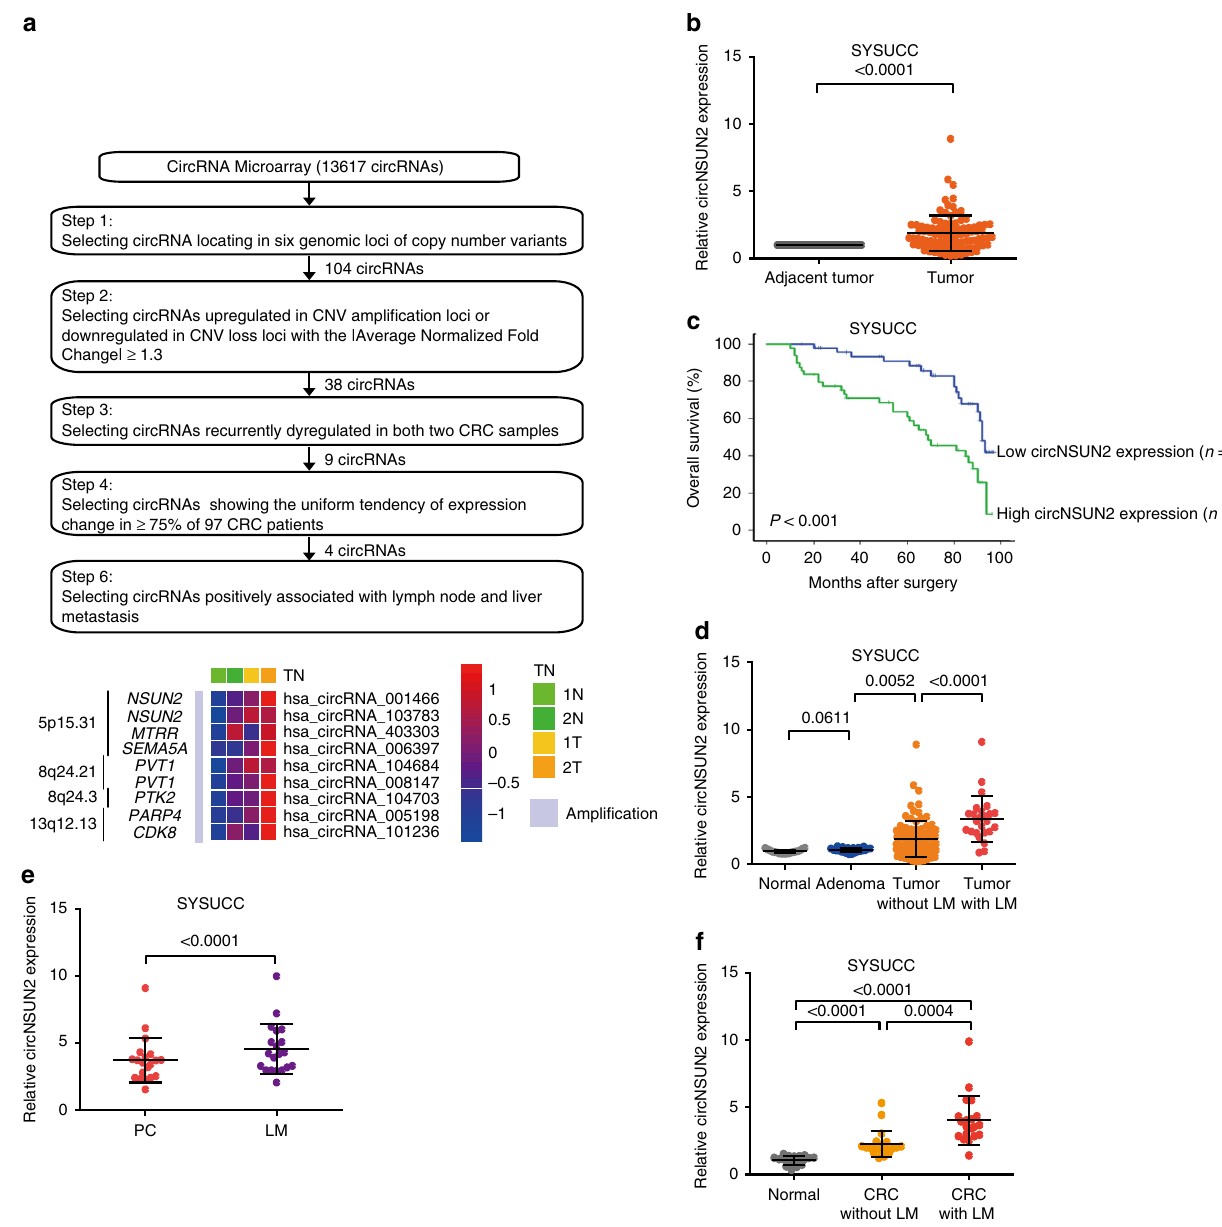
Fig. 1 CircNSUN2 was upregulated in CRCs with liver metastasis (LM). a Top, fl owchart illustrating the screening criteria of potential regulatory circRNAs enriched in CRCs. Bottom, clustered heatmap showing the dysregulated expression of circRNAs occurrent in both two CRC samples (the |average normalized fold change| ≥ 1.3) within susceptibility loci of CRC analyzed by CircRNAs Microarray. b qRT-PCR analysis of circNSUN2 expression in 97 CRC tissues and matched adjacent normal tissue. Data represent mean ± S.D., the P value was determined by a two-tailed paired Student ’ s t test. c Kaplan − Meier analysis of OS in CRC patients with low versus high expression the circNSUN2 from SYSUCC cohorts. The P value was determined by a Log-rank test. d qRT-PCR analysis of circNSUN2 expression from 18 normal colorectal tissues, 22 colorectal adenomas, 97 CRC patients without liver metastasis and 25 CRC patients with liver metastasis. Data represent mean ± S.D., the P values were determined by an unpaired Student ’ s t test. e qRT-PCR analysis of circNSUN2 expression in 20 pairs of primary colorectal cancer tissues (PC) and matched liver metastasis tissues (LM) surgically obtained from the same patients. Data represent mean ± S.D., the P value was determined by a two-tailed paired Student ’ s t test. f qRT-PCR analysis of circNSUN2 expression in serum from 18 normal control, 20 CRC patients without LM and 20 CRC patients with LM from the SYSUCC. Data represent mean ± S.D., the P values